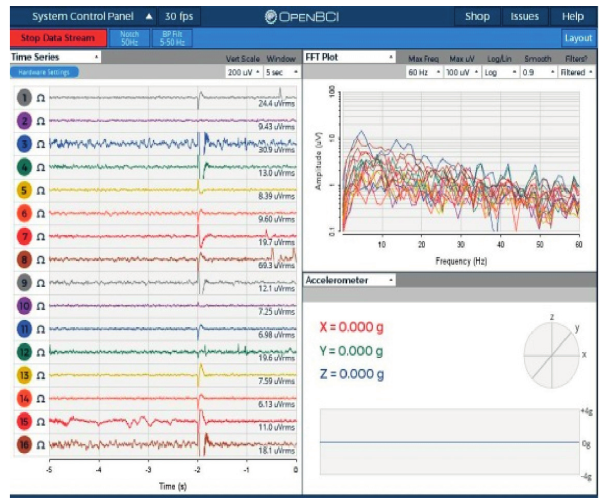
Figure 7: The EEG of grasp action idea in the dynamic state.